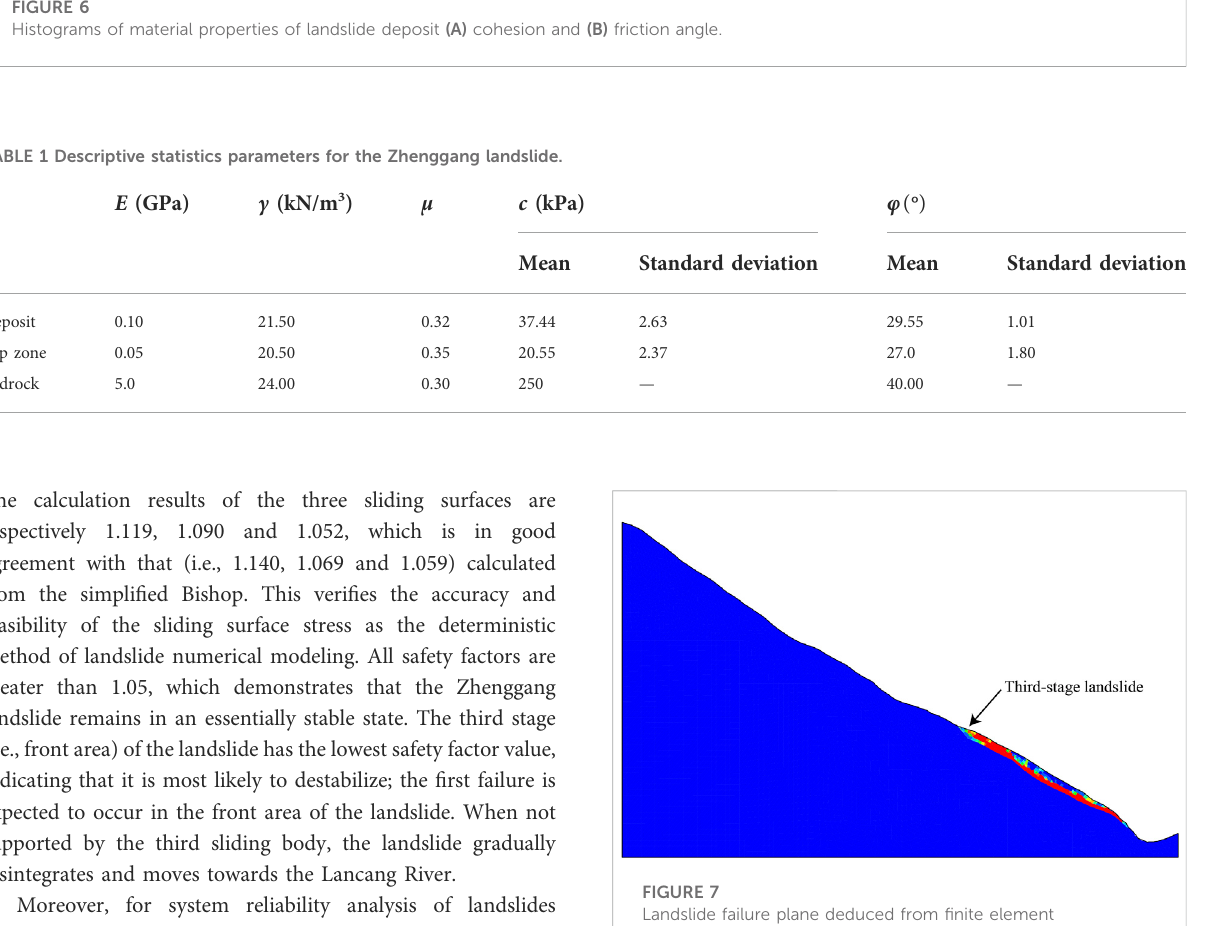
FIGURE 7 Landslide failure plane deduced from fi nite element